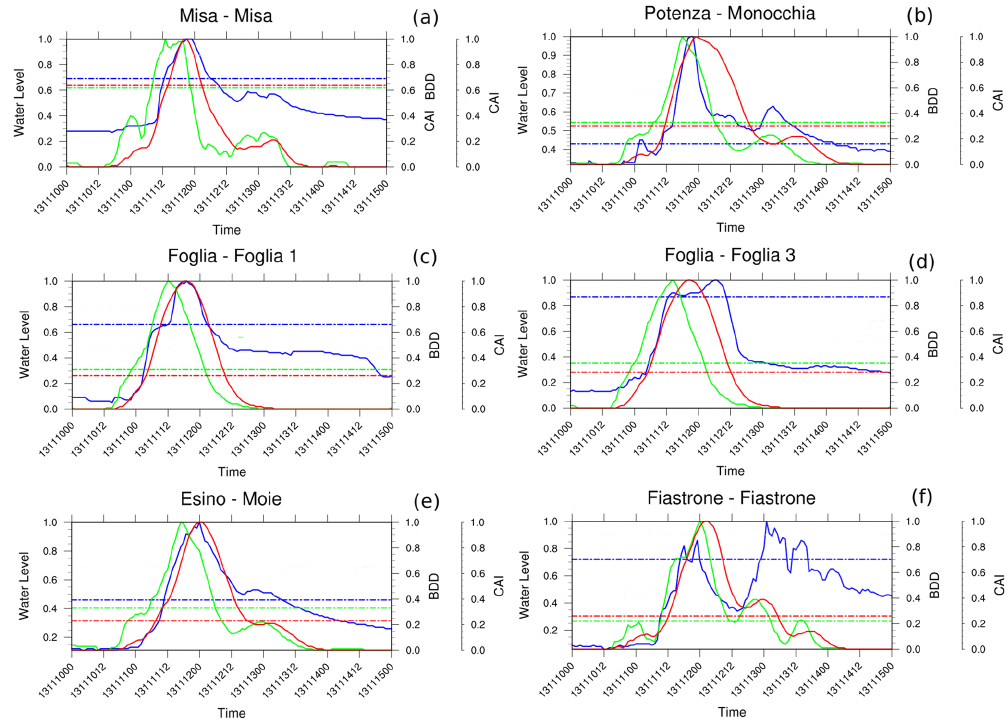
Figure 11. Time series comparison for six hydrometric stations: BDD hourly profile (red line), BDD moderate threshold (flat red line), CAI hourly profile (green line), CAI moderate threshold (flat green line), hydrometric-level hourly profile (blue line) and hydrometric-level moderate threshold (flat blue line). Quantity profiles and related thresholds are